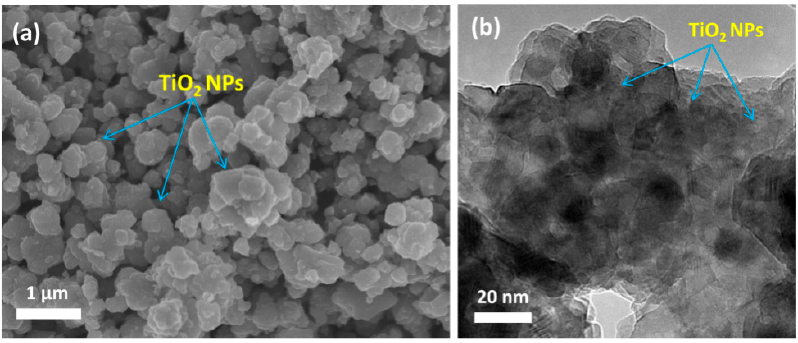
Figure 1. ( a ) SEM and ( b ) HR-TEM images for TiO 2 NPs.